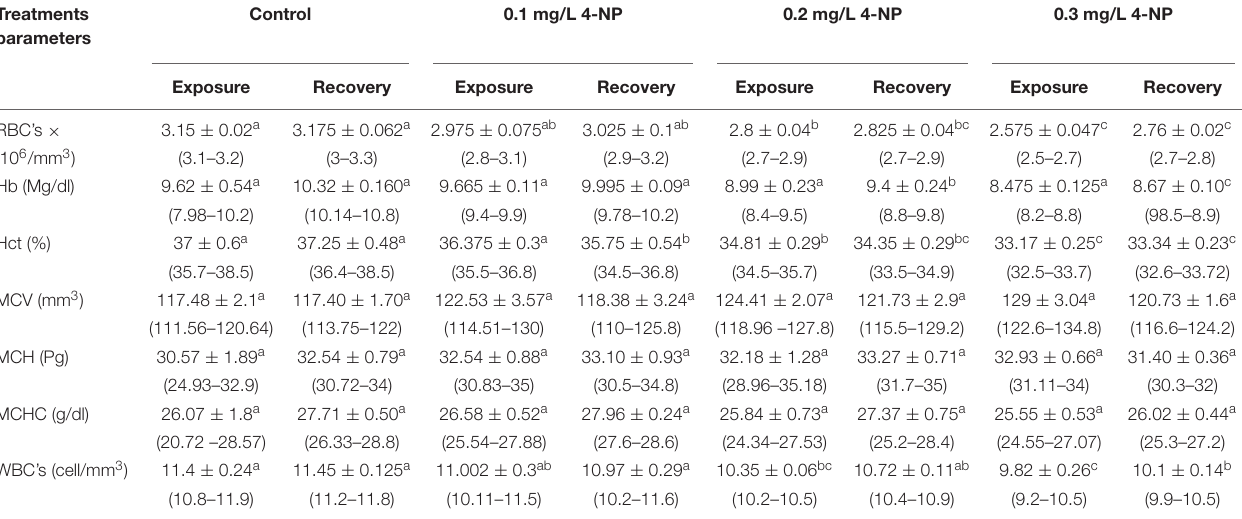
TABLE 2 | Effect of different doses of 4-NP on the hematological parameters mean ± SE (range) of the African catfish C. gariepinus after exposure to 4-NP for 15 days and recovery for 15 days ( n = 3). Treatments parameters